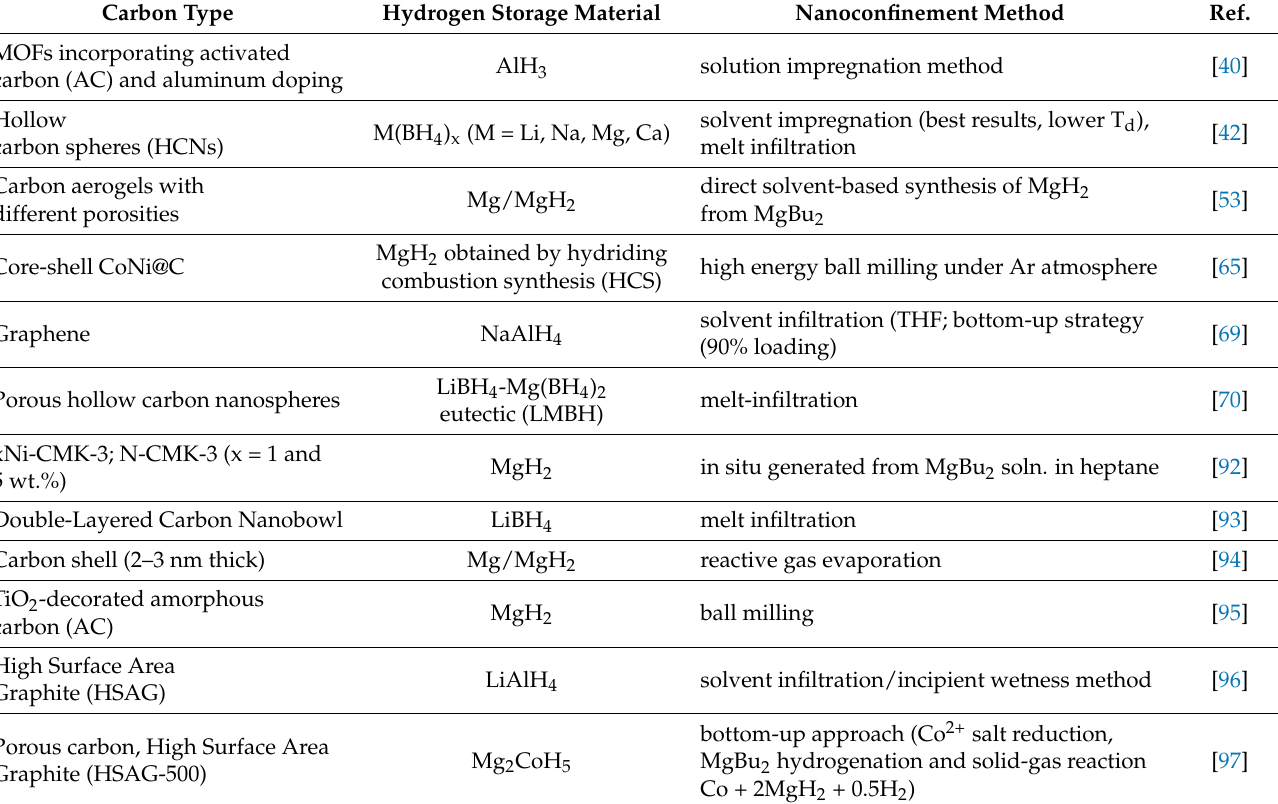
Table 2. Recent progress in carbonaceous-based supports for nanoconfined hydrogen